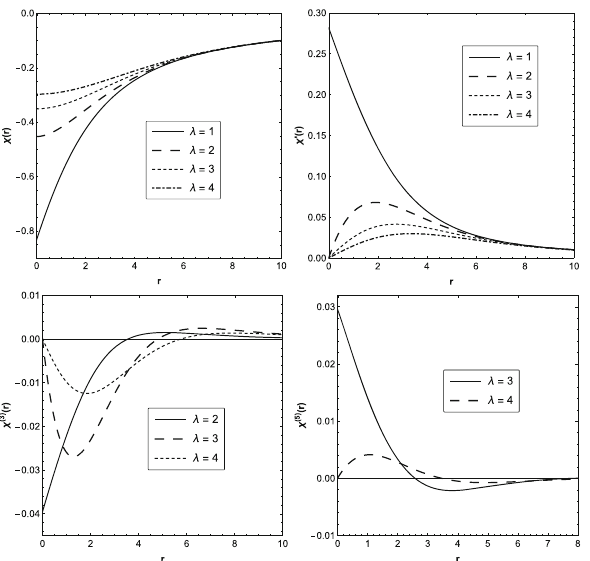
Fig. 1 Numerical evaluation of χ( r ) and its first odd-order derivatives for the Kuz’min form factor for λ ∈ { 1 , 2 , 3 , 4 } in (61)